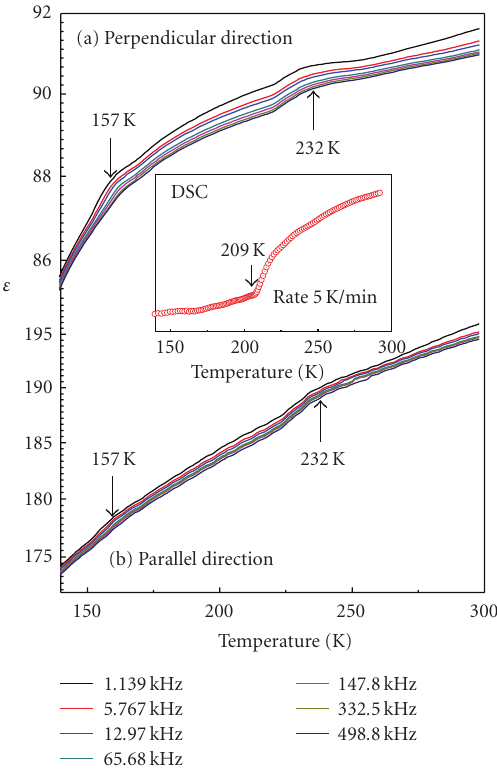
Figure 4: The temperature dependence of dielectric constants, (a) perpendicular direction; (b) parallel direction inset: DSC curve measured of BIT sample on